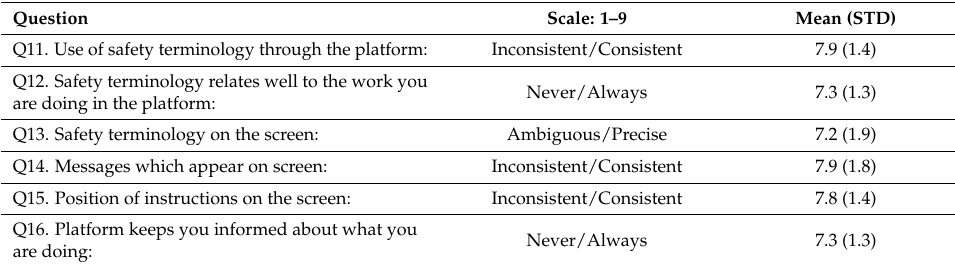
Table 6. Results of QUIS Part 3—Safety Terminology and Platform Information.